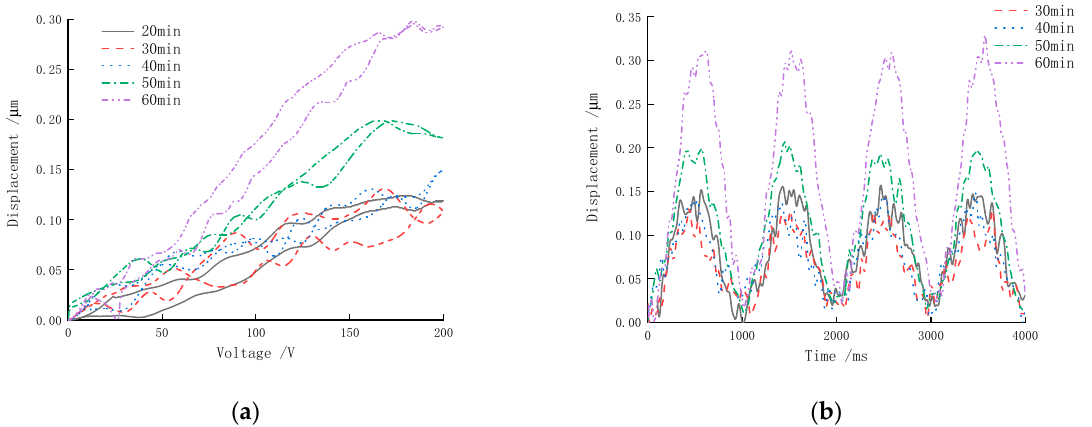
Figure 13. Displacement versus the polarization time: ( a ) response curves; ( b ) time-domain curves (four cycles).